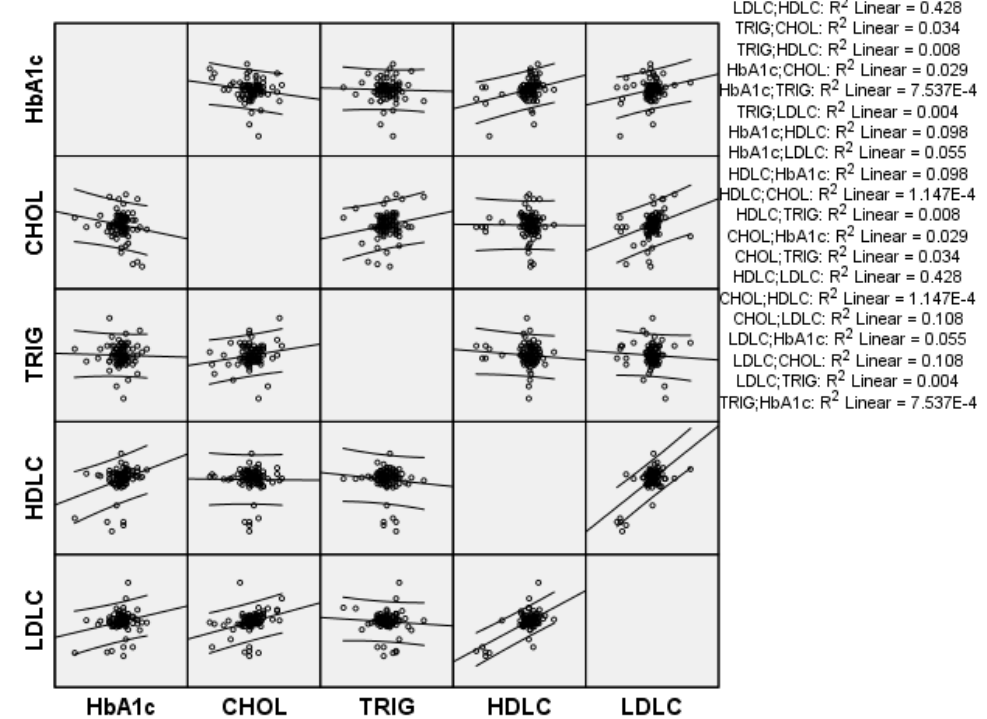
Figure 2. Plot matrix of correlation between ∆ change mean differences in the intervention group of lipid and glycemic profiles.